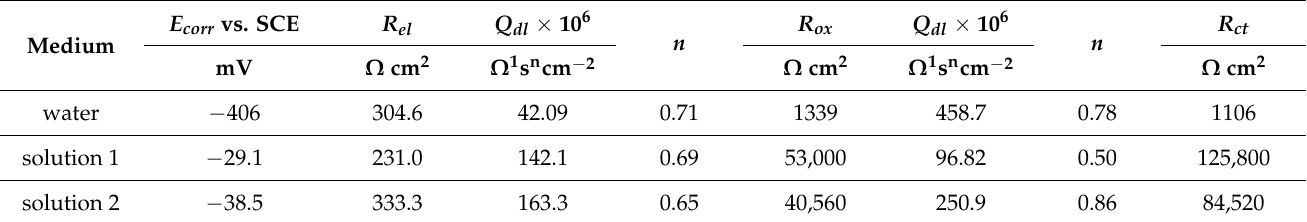
Table 3. Impedance parameters of the tested HTCS-130 tool steel.